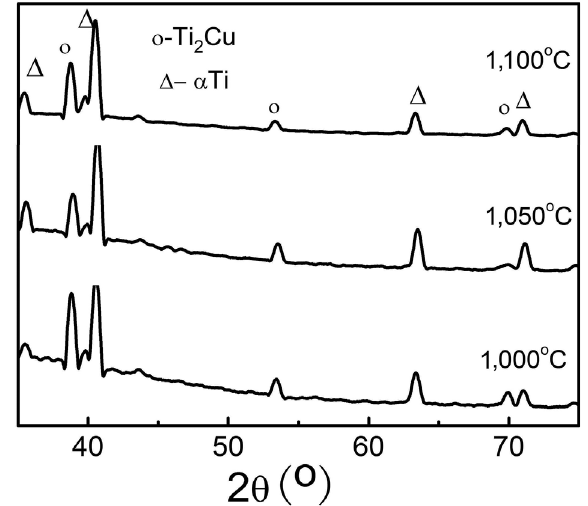
Figure 2: A schematic of the tensile specimens (two dimensional) with dimensions. All dimensions are in mm.